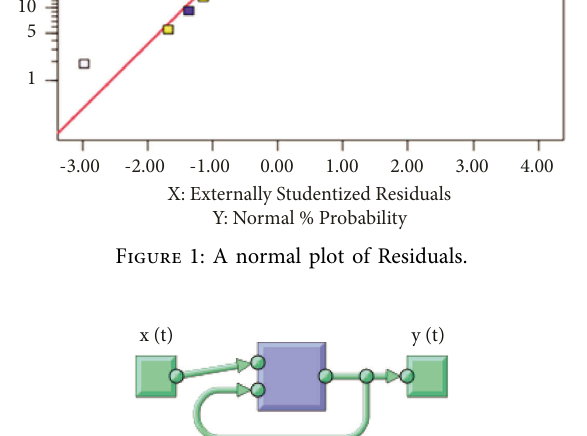
Figure 2: Two-layered feed-forward NARX